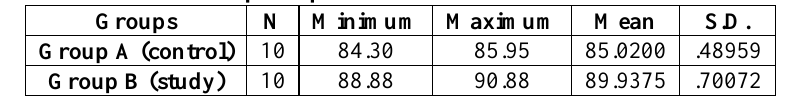
Table 5: Descriptive parameters of hardness number test